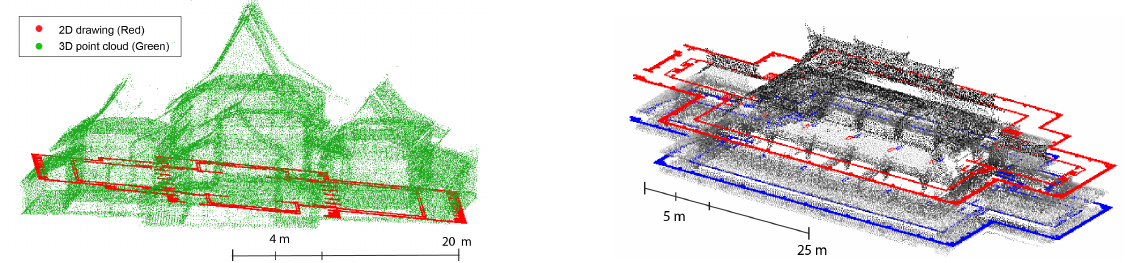
Figure 2. LEFT : First result of the registration of the discretized 2D plan on the 3D point cloud using ICP — RIGHT : Ambiguities related to the possible positions of the 2D drawing in the point